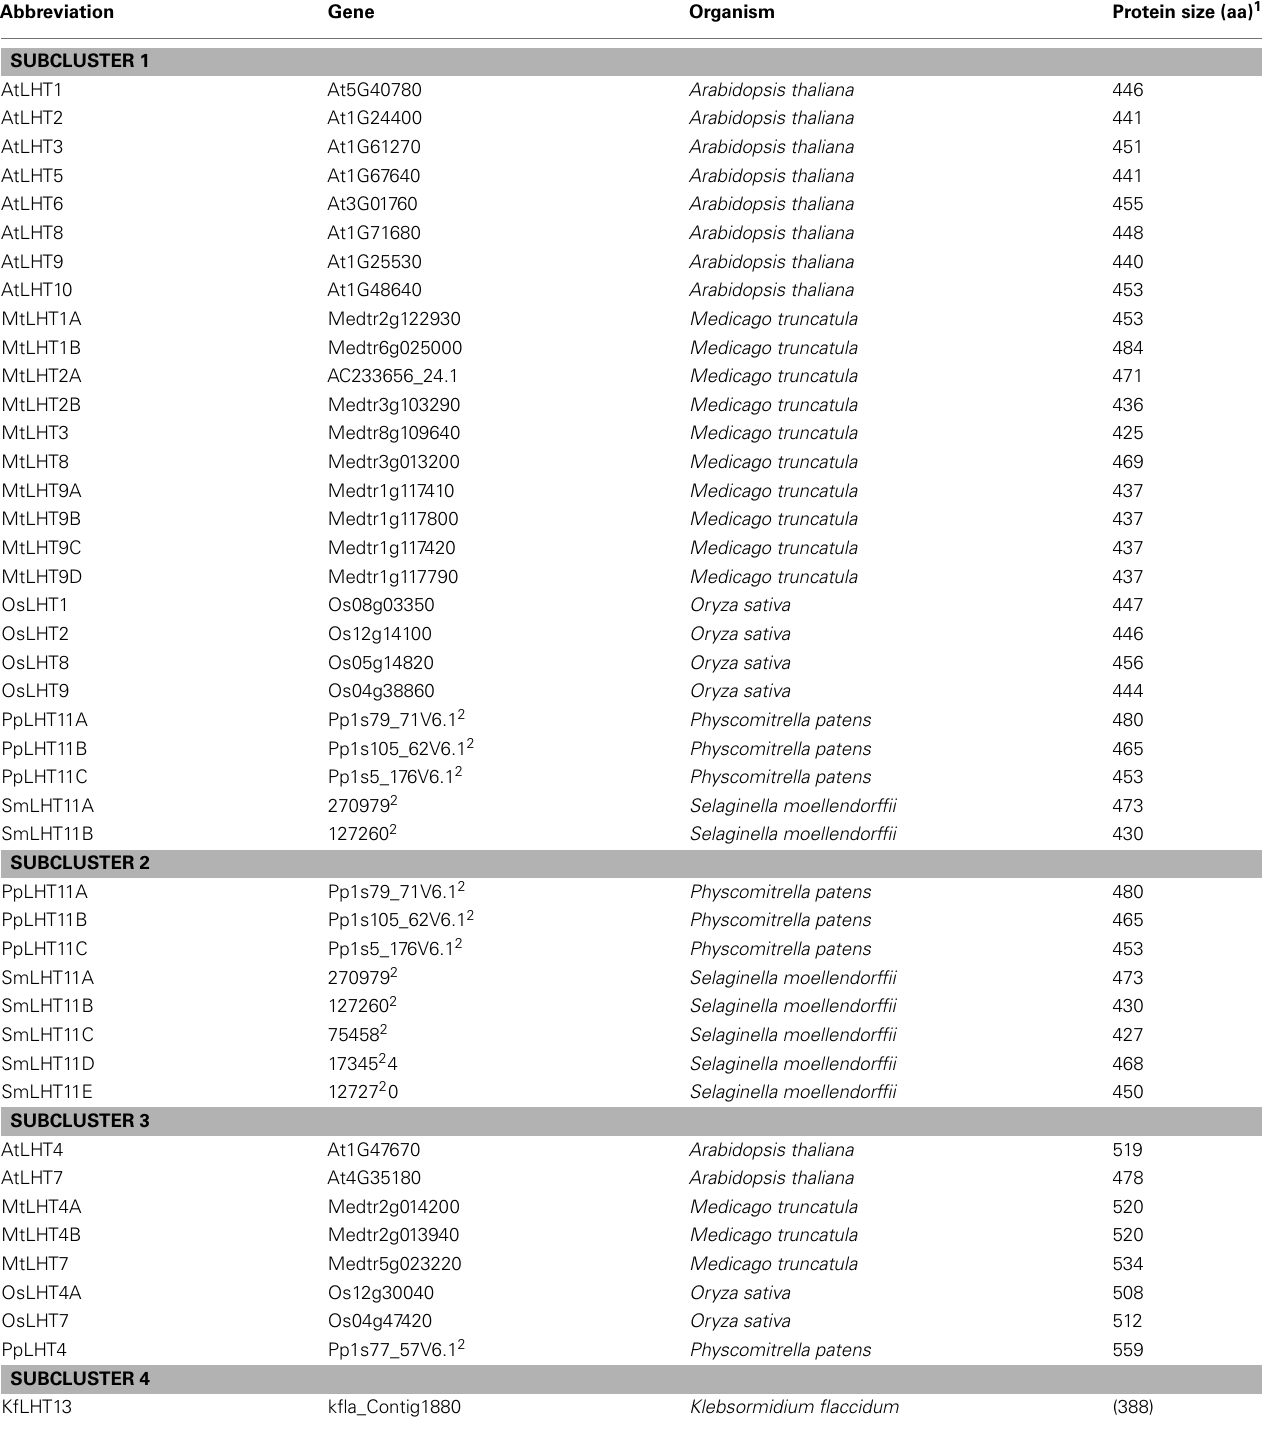
Table 2 | Lysine–histidine-like transporters protein sequences sorted by